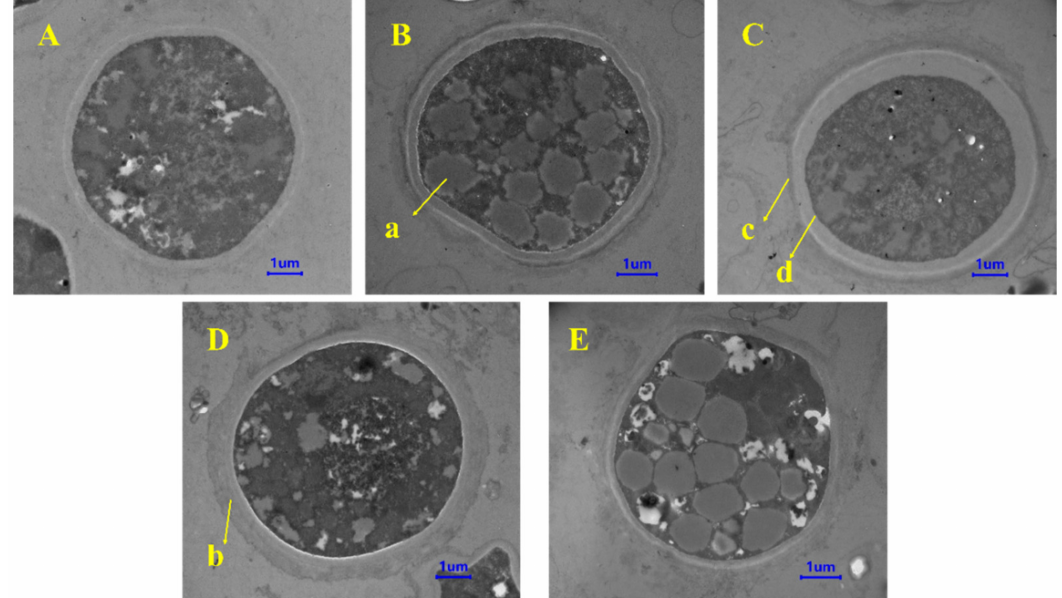
Figure 3. Transmission electron microscopy (TEM) images of chlamydospores: ( A ) control, ( B ) mannitol, ( C ) glycine betaine, ( D ) N-A-G, and ( E ) trehalose. The scale bar is 1 µ m. ( a ) Fat droplet, ( b ) diffuse outer layer, ( c ) outer wall, and ( d ) inner